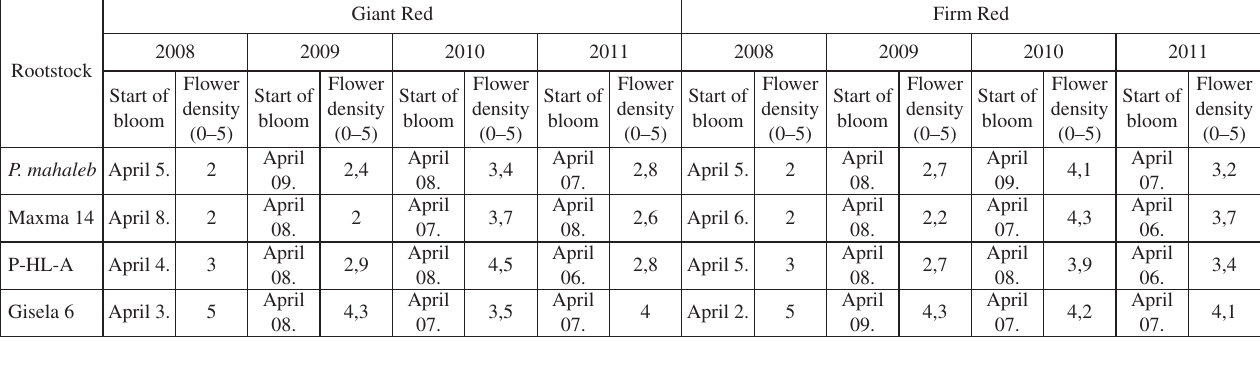
Table 4: Beginning of bloom and flower density of sweet cherry varieties (Nagykutas, 2008–2011)